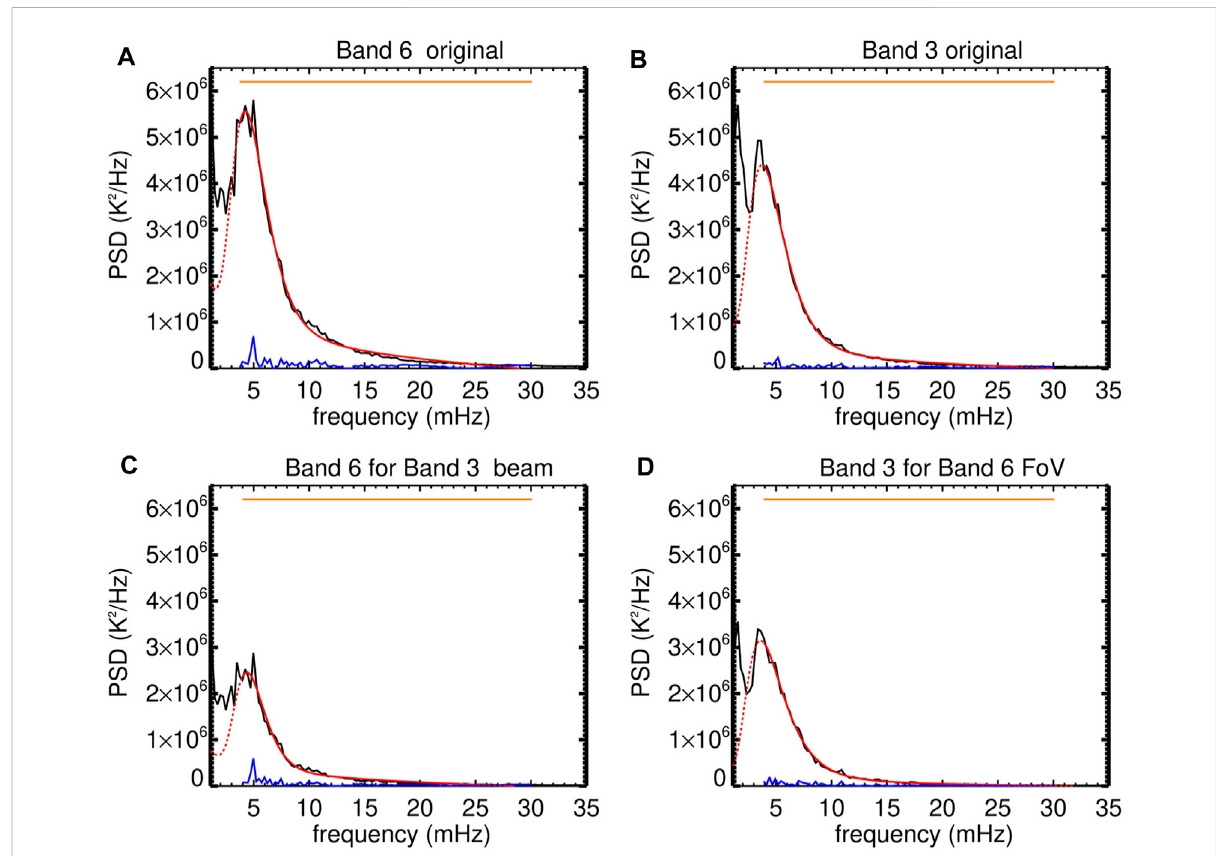
FIGURE 4 Quiet-Sun p -mode oscillations observed at 3 and 1.25 mm by ALMA. Black lines correspond to the spatially averaged PSDs, red lines to their fi ttings, and blue lines to the absolute residuals between the observed PSDs and the associated fi ttings. Panels (A , B) correspond to the original Band 6 and Band 3 observations, panel (C) to Band 6 observations at Band 3 spatial resolution and panel (D) for Band 3 observations corresponding to the Band 6 FoV (from Nindos et al., 2021). Reproduced with permission ©